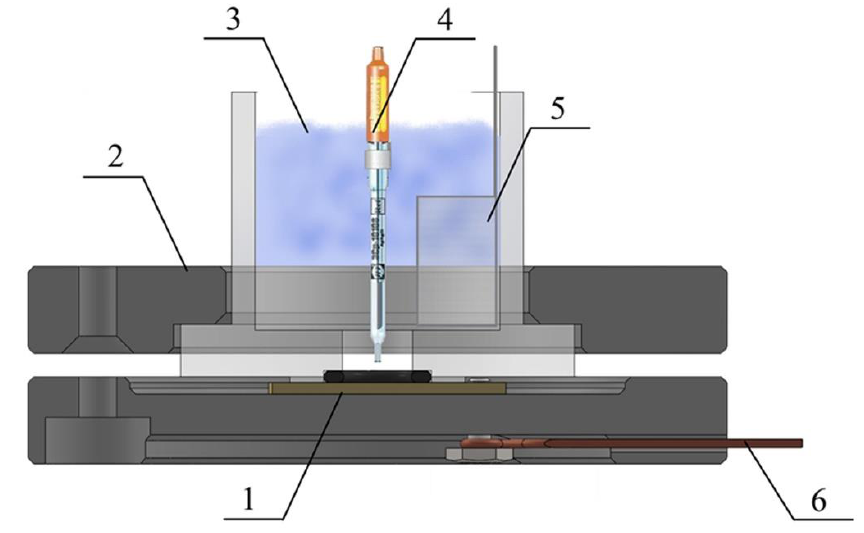
Figure 1. Tree electrodes corrosion cell: 1 — working electrode (Sample), 2 — corrosion cell, 3 — Hanks ’ solution (electrolyte), 4 — reference electrode (Ag/AgCl sat ), 5 — counter electrode (platinum mesh), 6 — current connector.